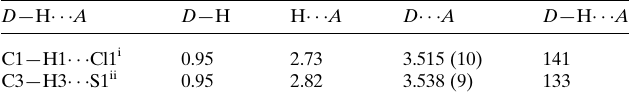
Table 2 Hydrogen-bond geometry (A˚ , (cid:3) ) for II .